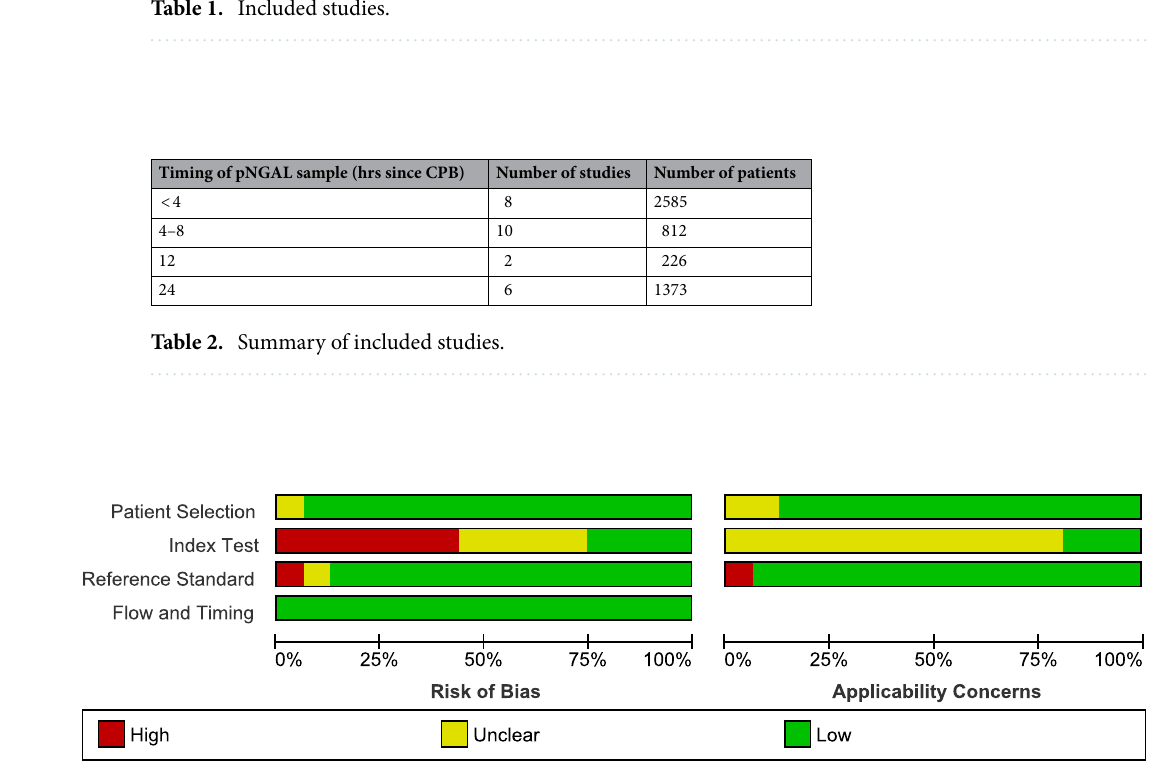
Figure 2. Risk of bias assessment using the QUADAS-2 tool: overall